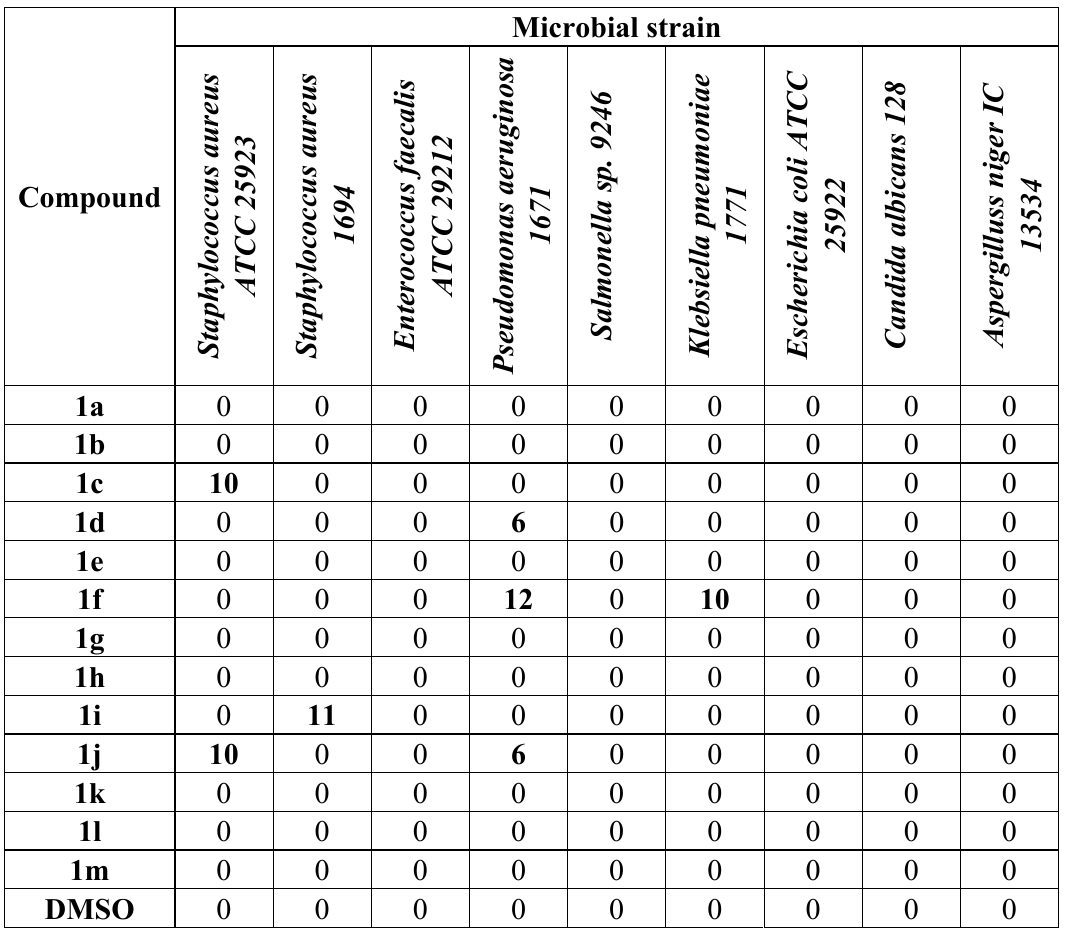
Table 1. Results of the qualitative screening of the susceptibility spectra of various microbial strains to the newly synthesized compounds (diameter of the growth inhibition zone expressed in mm).